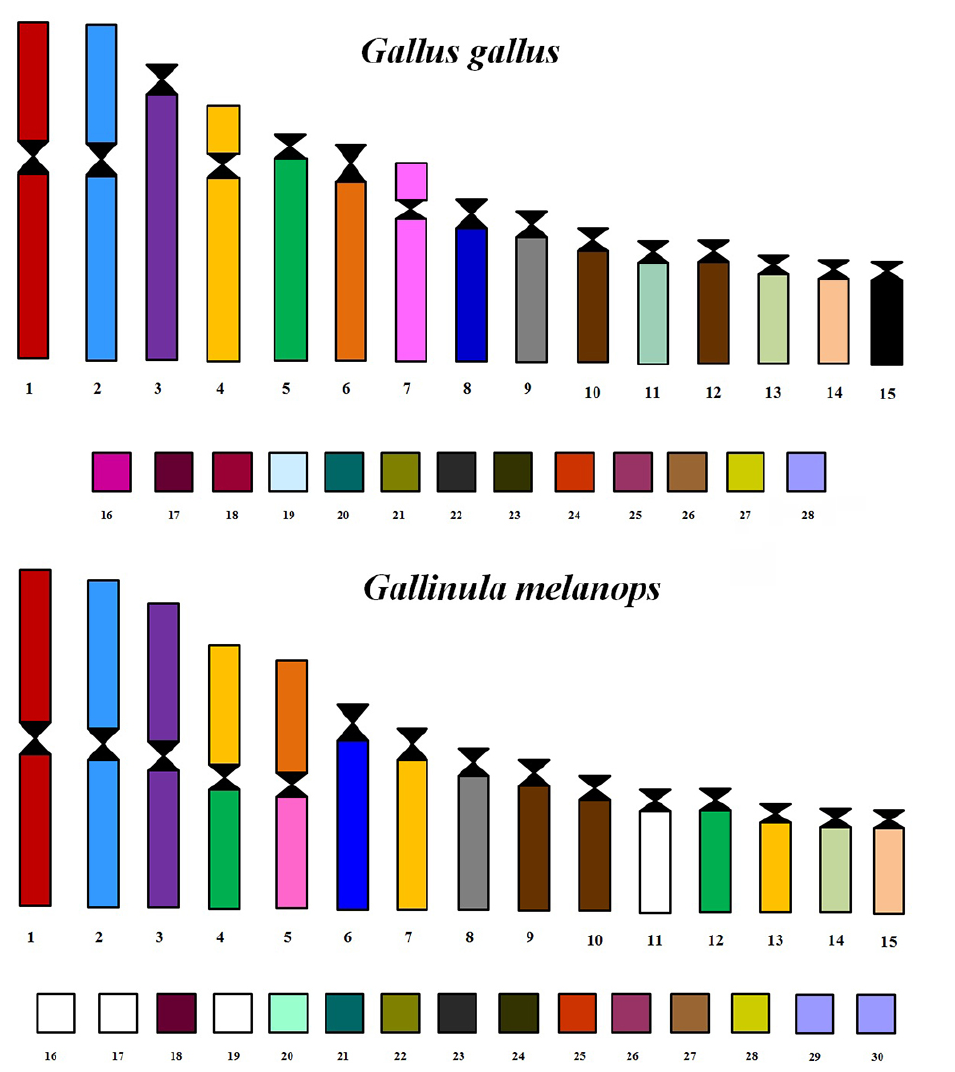
Figure 4 – Homology map between chromosomes of Gallus gallus and Gallinula melanops determined by FISH experiments with GGA painting probes (GGA1-14) and GGA BAC clones of microchromosomes from 17-28. A) reporting the colour guide to GGA painting probes and BAC clones, and B) reporting the homology between the chromosomes of these two species. Segments not hybridized are indicated in white. Chicken probe 11 did not work and BACs 15 and 16 were not used in this study. The BAC 20 of Zebra finch is represented by the BAC 20 of